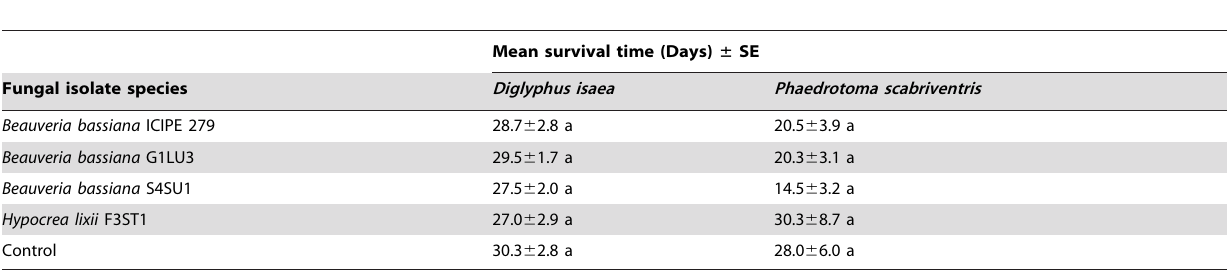
Table 3. Mean survival time of Diglyphus isaea and Phaedrotoma scabriventris F1 progeny whose parents were exposed to Liriomyza huidobrensis -infested Vicia faba plants colonized by the different endophyte fungal isolates.